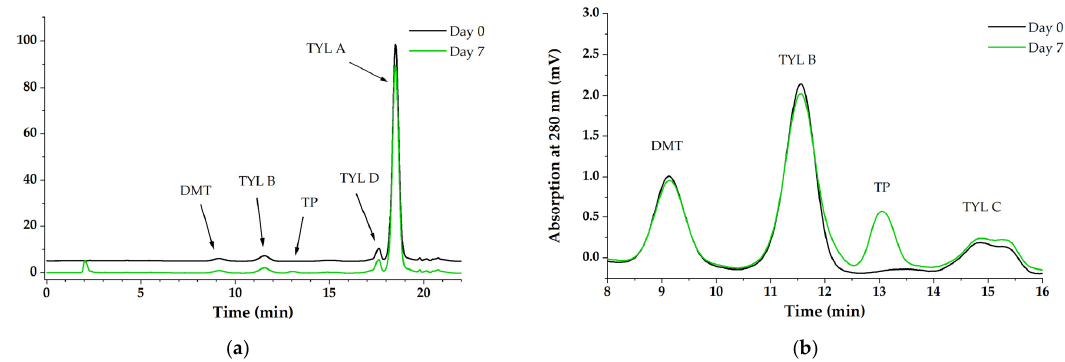
Figure 4. Comparative representation of HPLC-UV-chromatogram of BA with P. fluorescens exposed to TYL A at day 0 and day 7. ( a ) The overall outcome of UV-chromatogram; ( b ) Enlarged section of the UV-chromatogram showing concentration changes of TYL B and appearance of transformation product (TP) eluting between TYL B and TYL C.